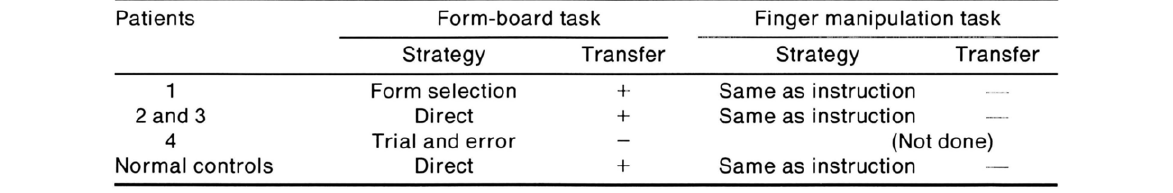
FIG. 2. Form-board task (left) and finger manipulation task (right). TABLE II Subjects' strategy and transfer of